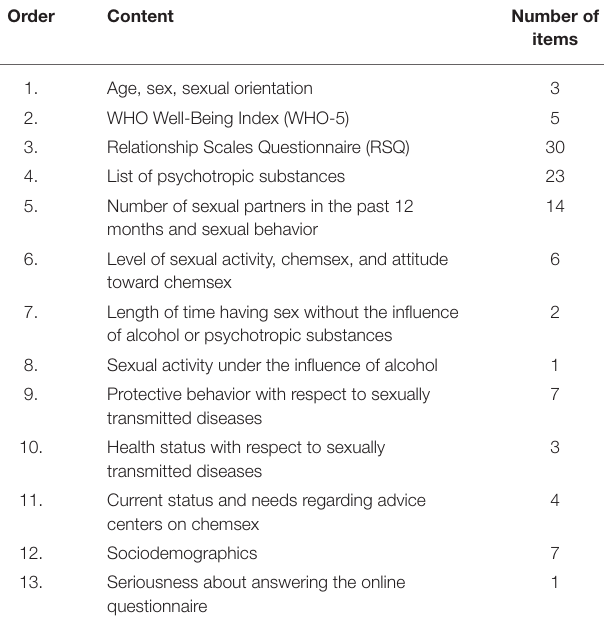
TABLE 1 | Content of the